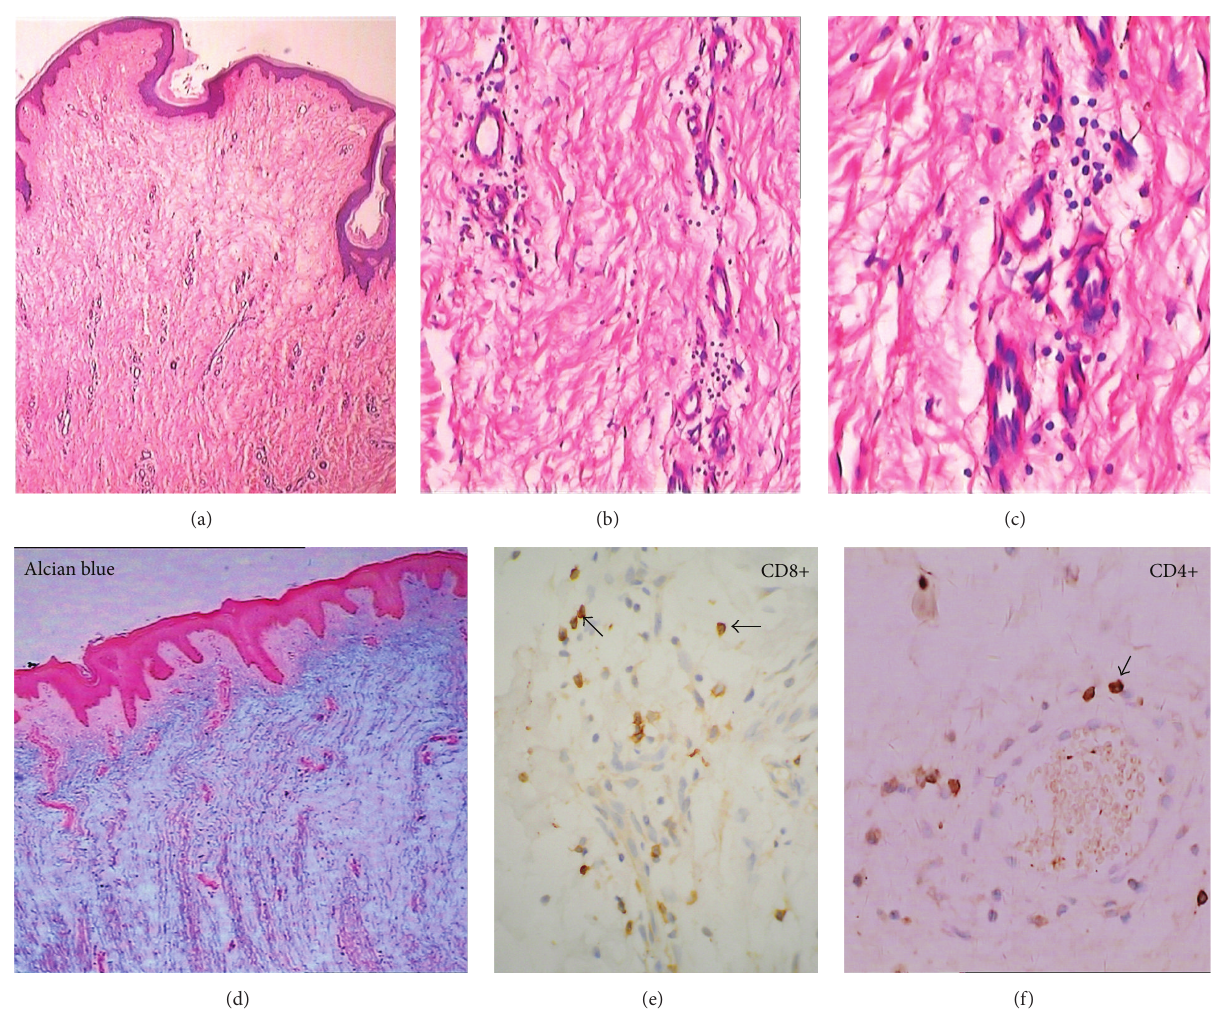
Figure 11: Large amounts of mucopolysaccharide deposits, numbers of newly formed capillaries, and a perivascular lymphocyte infiltrate at active stage of PTM. (a) H&E × 4. The epidermis was essentially normal. Just below the epidermis is a relatively unaltered strip of papillary dermis. The upper layer of reticulate dermis was obvious mucin degeneration with widely separated, frayed, and fragmented collagen bundles. In the lower layer of reticulate dermis were seen numbers of newly formed capillaries, a perivascular inflammatory cell infiltrate, and proliferation of fibroblasts. (b) H&E × 20 and (c) H&E × 40. Perivascular and dermal lymphocyte infiltrates were seen. (d) H&E × 4. Alcian blue staining showed large amounts of mucopolysaccharide deposits in the lower layer of papillary dermis and reticulate dermis. (e) × 40. Immunohistochemical staining by anti-CD8 monoclonal antibody showed a large proportion of infiltrates were CD8+ T lymphocytes (arrows) in the dermis and perivascular regions. (f) × 40. Immunohistochemical staining by anti-CD4 monoclonal antibody showed a CD4+ T-cell infiltrate in the dermis and perivascular